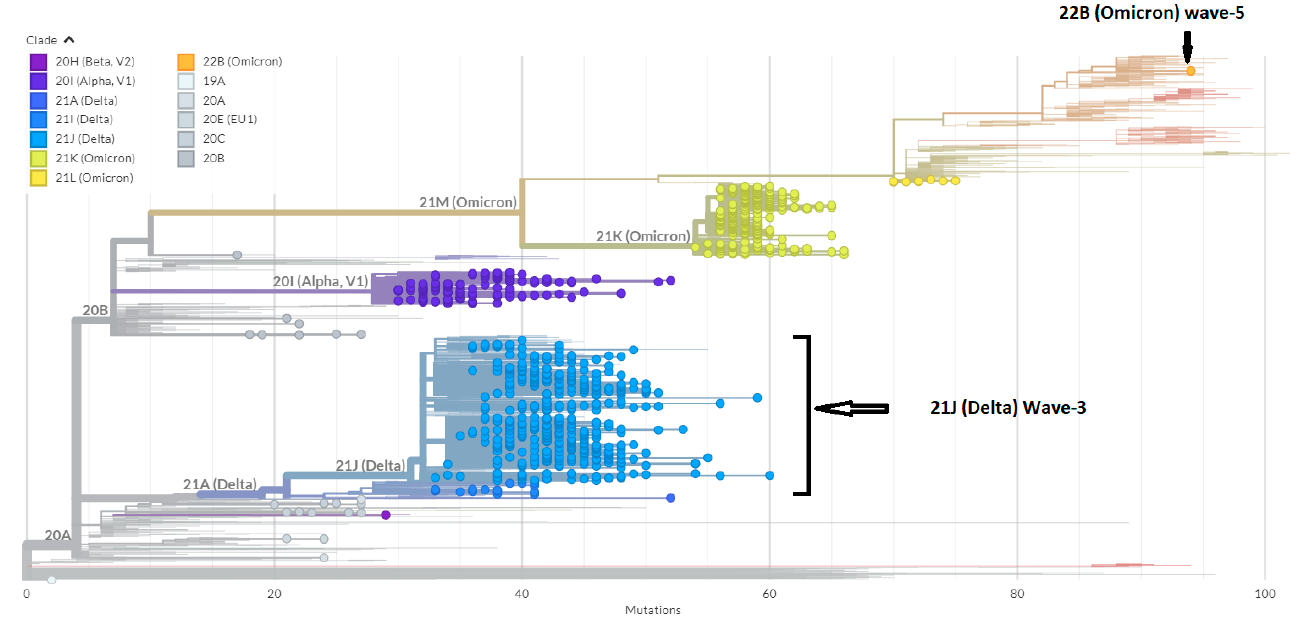
Figure 4. Phylogenetic tree of whole genome sequences from the third and fifth waves’ samples and the other Iraqi SARS-CoV-2 isolates from the beginning of the pandemic with all global isolates demonstrating the position and clustering of the named clades (Nextrain nomenclature). The tree was constructed without any restrictions using the Nextclade web service (https://clades.nextstrain.org/ accessed on 1 November 2022).